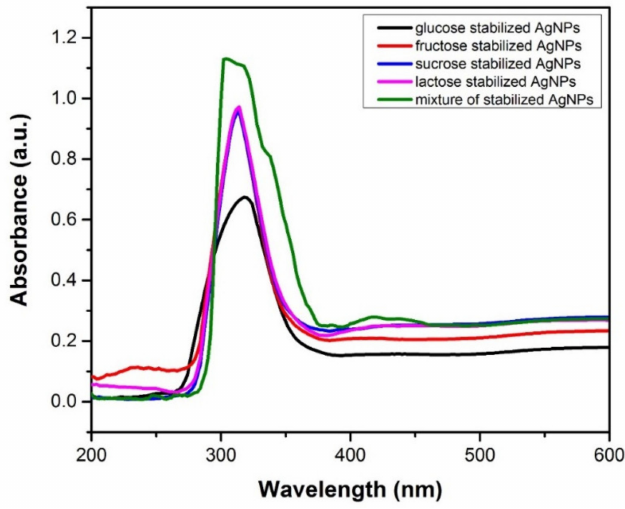
Figure 5. UV absorption spectra of individual and mixture of stabilized